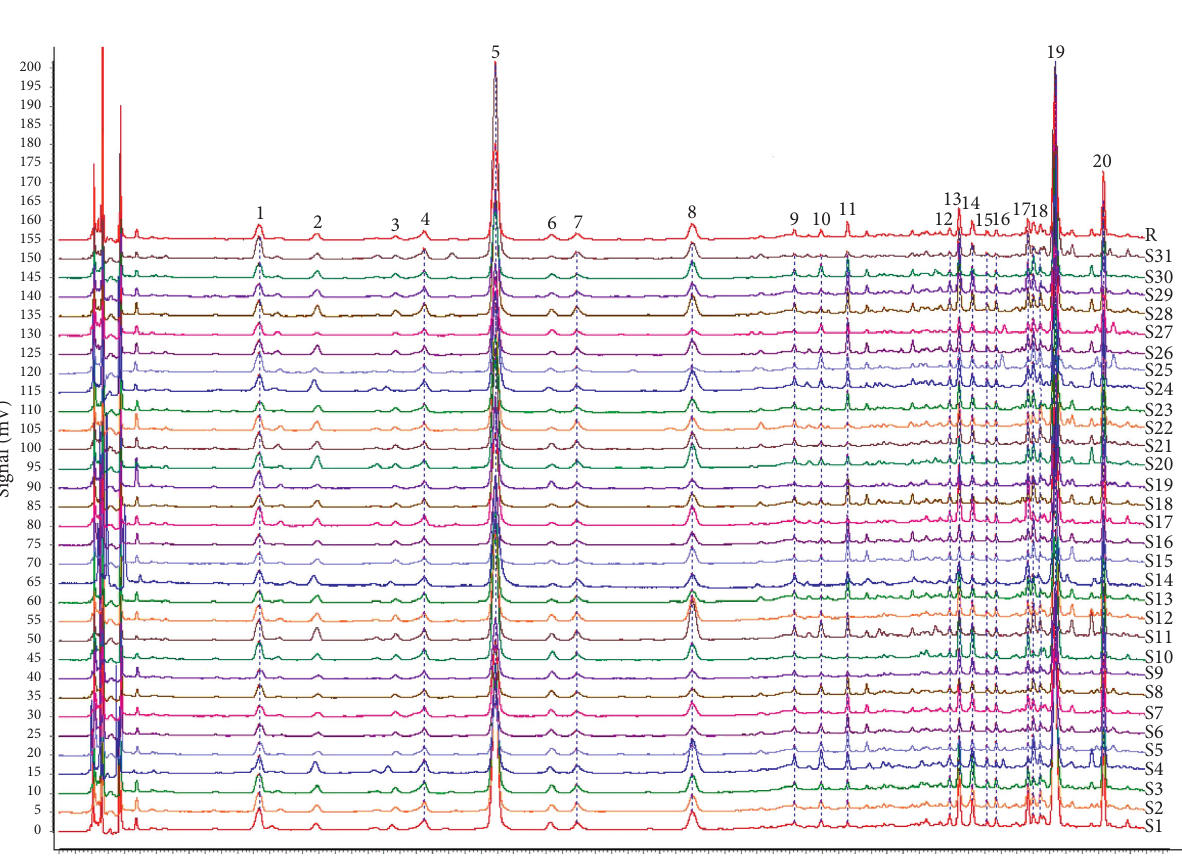
Figure 1: Chromatograms of 31 batches of A. capillaris (S1–S31) and the reference chromatogram